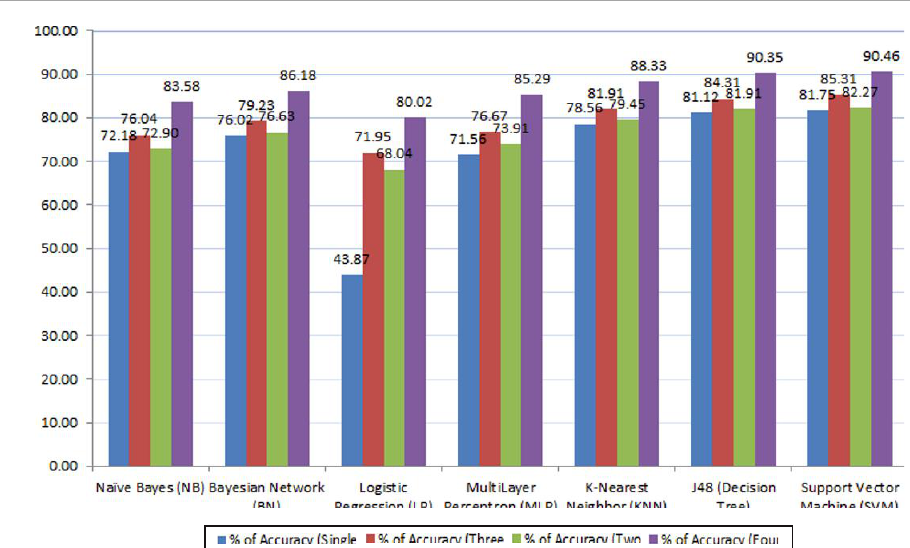
FIG. 10. RECOGNITION ACCURACY COMPARISON, 1 VS. 2, 3 AND 4 GROUPS OF ACTIVITIES